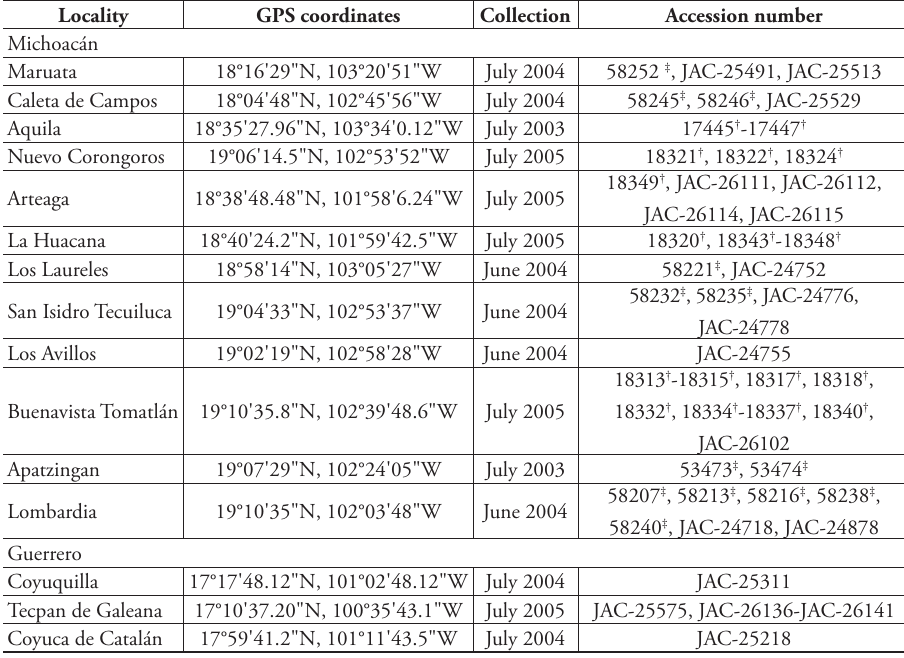
Table 1. Sampling localities in Mexico for Sceloporus pyrocephalus examined in this study.